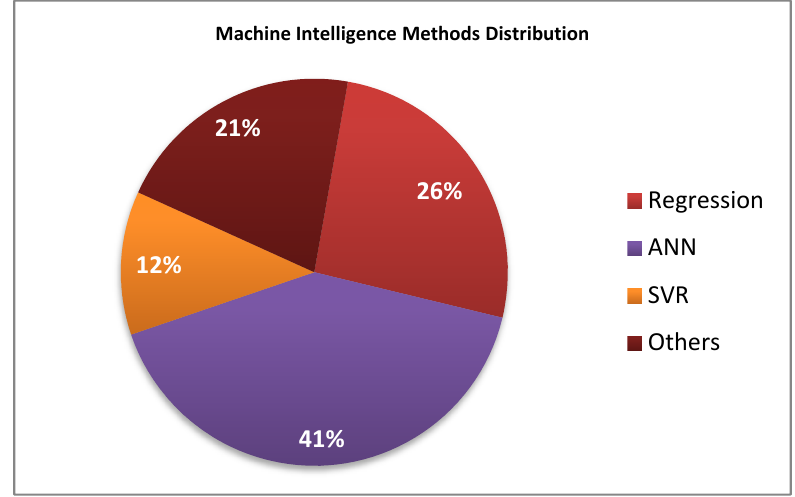
Figure 5. Composition of the primary prediction approach type.